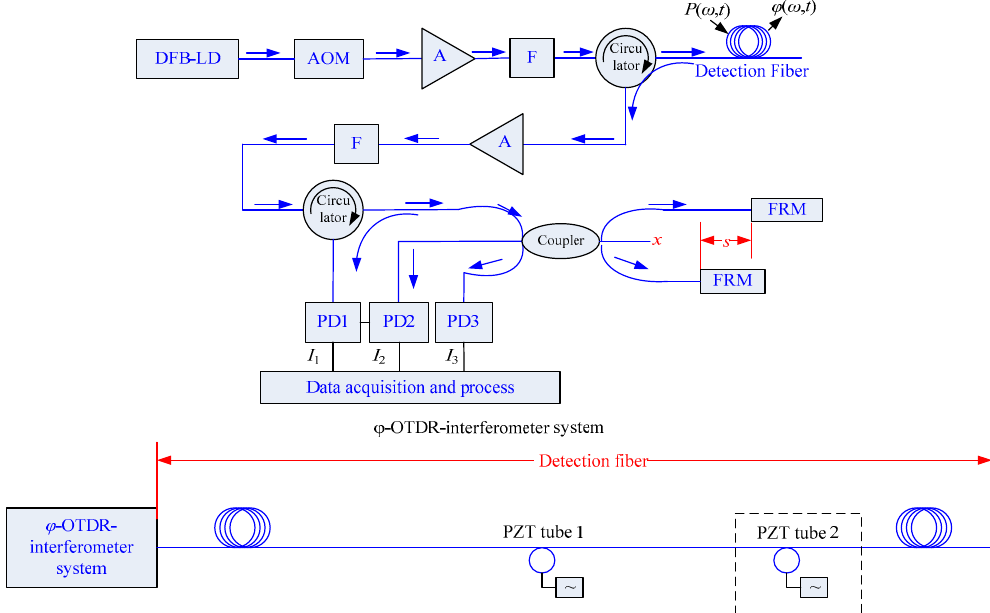
Fig. 1 Experimental setup for the Michelson interferometer of the φ -OTDR (DFB-FL: distributed feedback fiber laser; AOM: acoustic-optic modulator; A: erbium-doped fiber amplifier; F: optical fiber grating filter; FRM: Faraday rotation mirror; PD1–3: photodetectors; PZT: piezoelectric transducer).